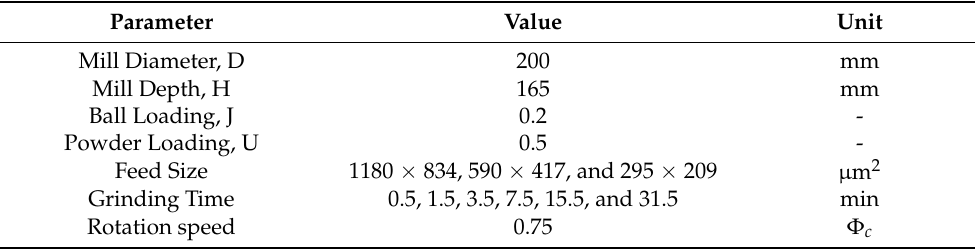
Table 1. Experimental conditions for grinding using ball